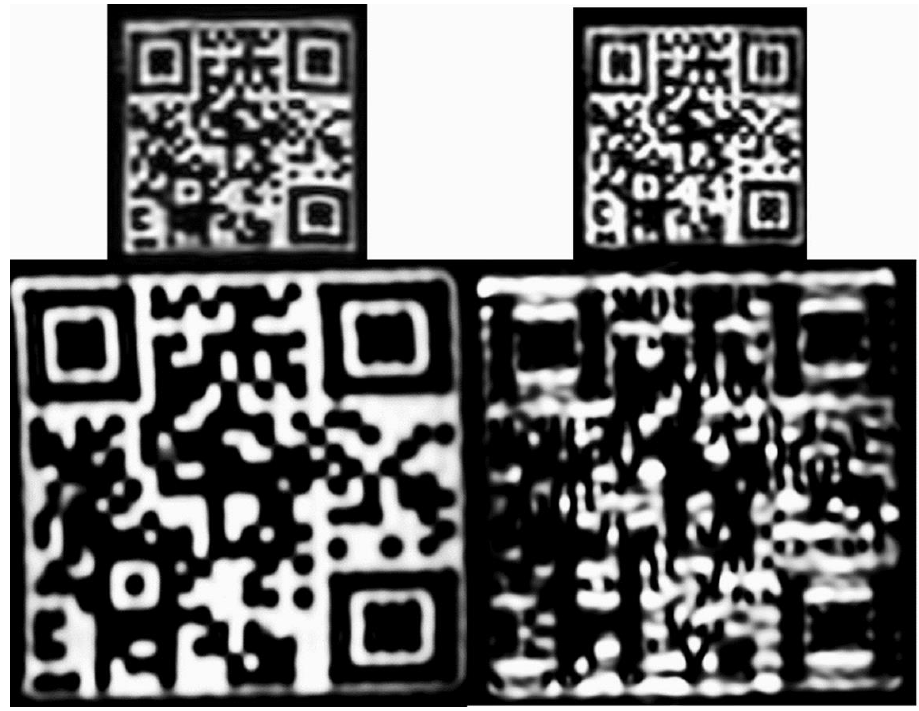
Figure 10. Representative coronal images from the small and the large QR phantom scans at 3 Tesla field strength and 1 × 1 × 1 mm 3 resolution. T1 and T2 contrast images are in the left and right columns, respectively. The encoded information can only be read out with a smartphone from the T1 image of the large QR